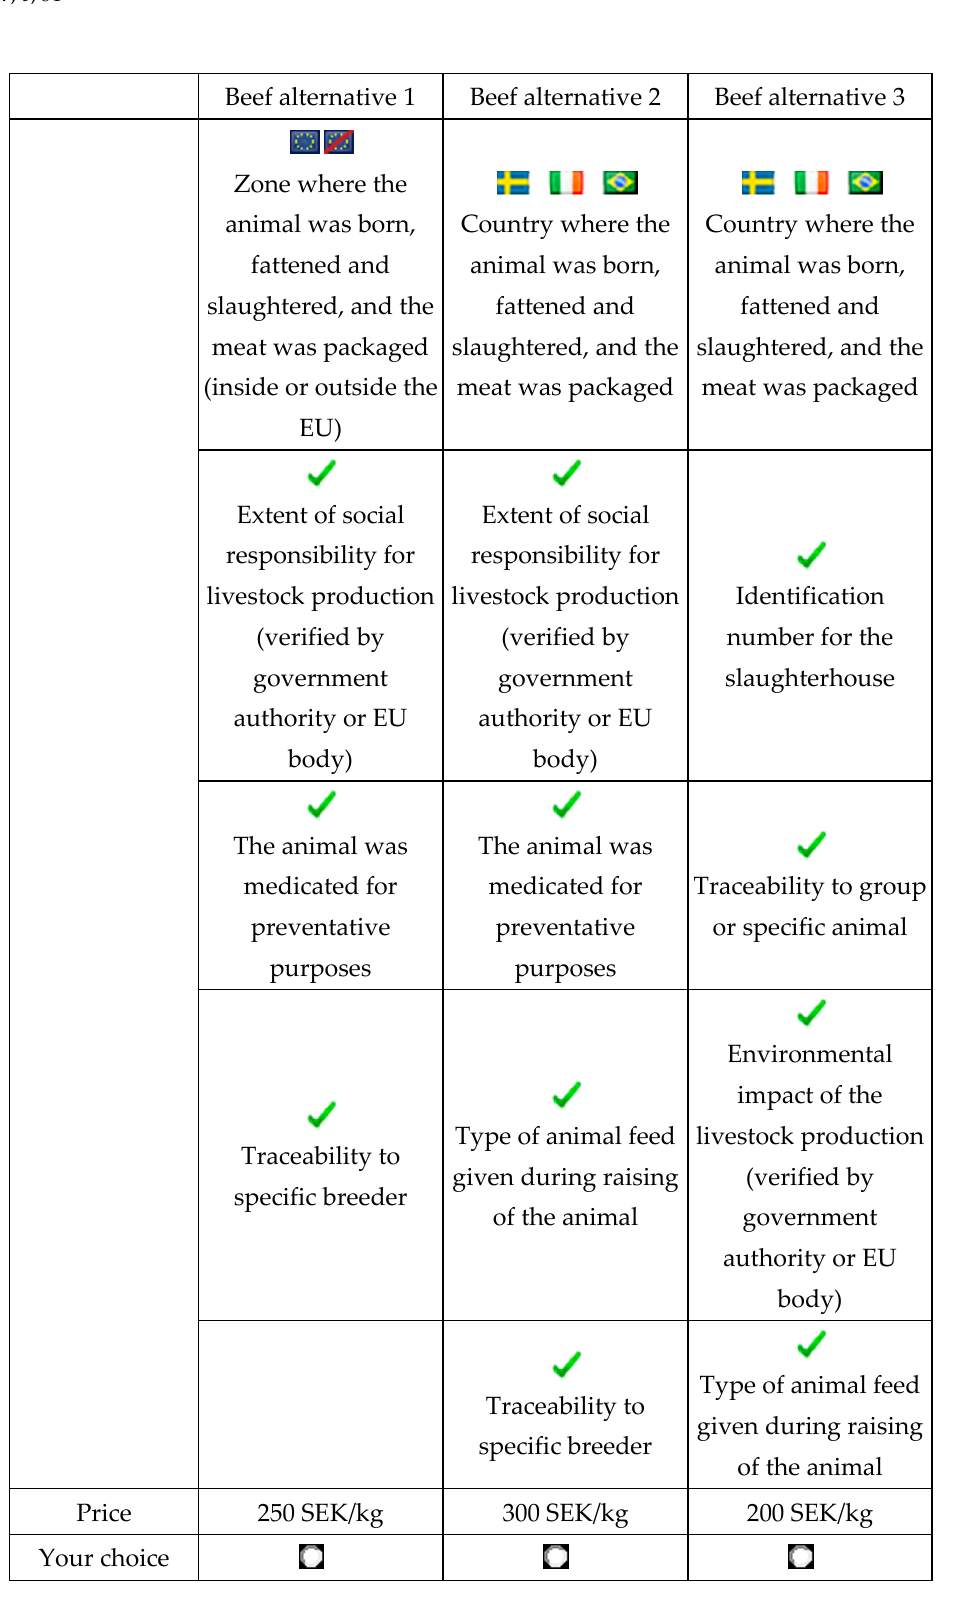
Figure 1. Illustration of a choice set.